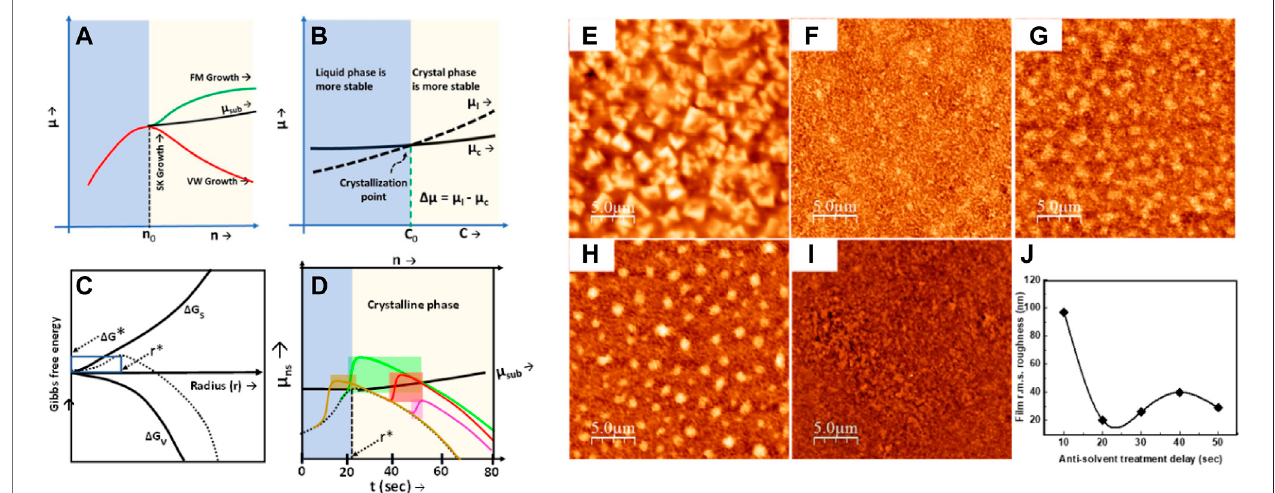
FIGURE4| Schematicdiagramofcontrollingthechemicalpotentialwiththehelpofantisolventtreatmentduringthecrystallizationofperovskite fi lms. (A) Changein the chemical potential as a function of the adsorbed particles/molecules (B) Change in the chemical potential from a liquid phase to crystalline phase (C) Variation of Gibbs free energy as a function of particle radius and (D) Proposed variation of the chemical potential during the antisolvent dripping. Dotted line represents chemical energy variation without antisolvent dripping, while solid lines represent the chemical energy variation at different antisolvent dripping delay time, (E – I) fi lm morphologyobtainedbydrippingtheantisolventat10,20,20,40,and50 softimedelay; (J) showsthevariationin fi lmroughnessinperovskite fi lmspreparedatdifferent antisolvent dripping delays. Reproduced with permission (Kumar et al., 2020). Copyright 2020, The Royal Society of Chemistry.